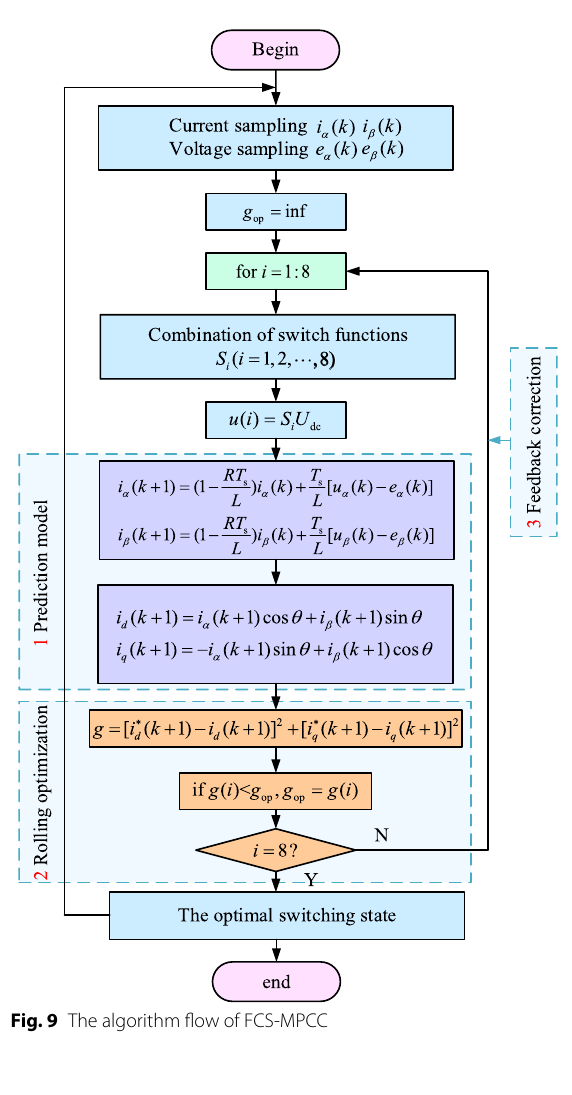
Fig. 9 The algorithm flow of FCS-MPCC